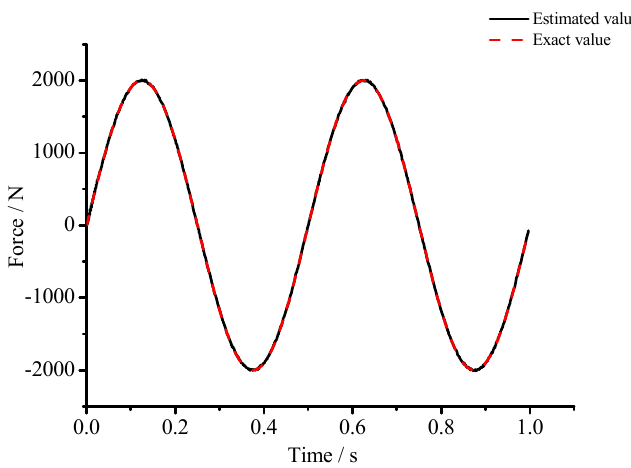
Figure 3. Estimation results of the sinusoidal input force ( Q w = 1 × 10 − 4 , σ = 1 × 10 − 8 ) .